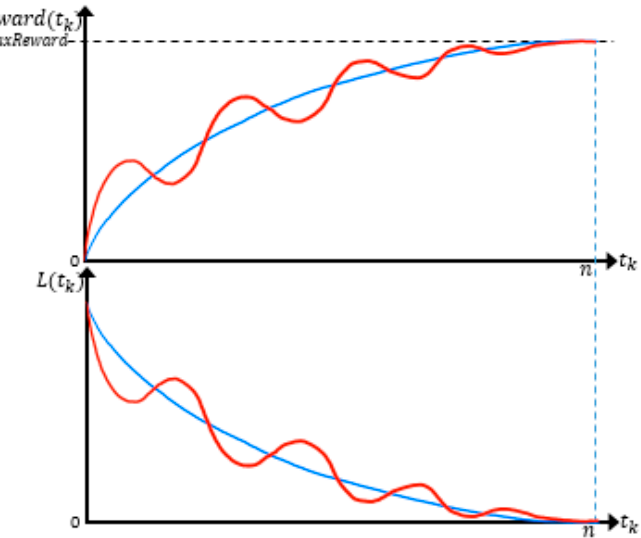
Figure 8. Example graphs of the relationship between the reward value and the Lyapunov function.